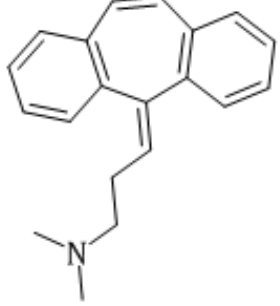
Figure 1: Chemical structure for